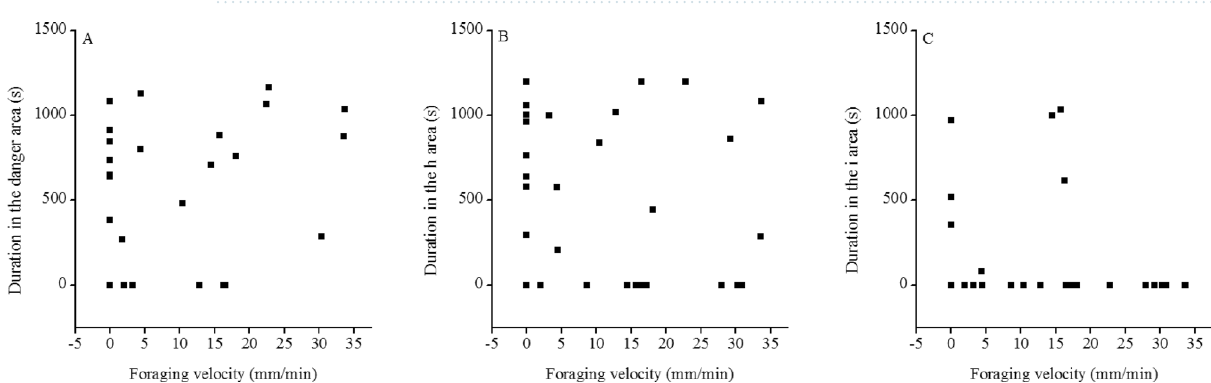
Figure 3. Experiment 3: correlation between foraging velocity and the duration in the danger area (g area) in Mesocentrotus nudus when they encountered conspecific alarm cues on the way to forage ( A ), correlation between foraging velocity and the duration in the h area ( B ), correlation between foraging velocity and the duration in the i area ( C ) when the kelp was around 5 mL and 0.5 mL conspecific alarm meters 12 . Therefore, the current result indicates adding conspecifics alarm cues around the kelp is an effectively approach to reducing the threat from sea urchins to the kelp beds. Conspecific alarm cues that appear between the kelp and the sea urchins significantly prevent foraging behav- ior of sea urchins (unpublished data). However, it remains unknown of whether adding conspecific alarm cues in critical areas probably prevent fasted sea urchins to forage. Sea urchins tend to move from the barrens with scarce macroalgae to the kelp beds with plentiful macroalage 13 . Starvation significantly enhances the foraging frequency of the sea urchin Echinometra mathaei 8 . Thus, effectively preventing fasted sea urchins from foraging the kelp is important for the management of kelp beds. In the present study, sea urchins fasted for 21 days did not move through the area with conspecific alarm cues when conspecific alarm cues appeared between the kelp and sea urchins. Besides, duration in the escape (f area) and danger (e area) areas did not differ significantly in the sea urchins fasted for 21 days. These results suggest that escape behavior overwhelms foraging behavior in fasted sea urchins when they are exposed to conspecific alarm cues. Although the sea urchin Heliocidaris cras- sispina fasted for one week was less sensitive to the cues of dead urchins 14 , M . nudus fasted for three weeks was sensitive to the conspecific alarm cues. It is likely that conspecific alarm cues from different sea urchin species have different effects on the fasted individuals. Together with our previous study, we suggest that conspecific alarm cues can effectively prevent the fasted sea urchins (at least M . nudus ) from foraging the kelp. Increasing evidences suggest that individual differences in foraging behavior are regulated by animal person- ality traits 15 . Bolder threespine sticklebacks Gasterosteus aculeatus tend to have strong foraging behavior 16 . Sea urchins overgraze the kelp through their strong foraging tendency. Thus, we hypothesize that the sea urchin with strong foraging ability probably moves through the area of conspecific alarm cues. The present study unexpect- edly found that there was no correlation between sea urchins with strong foraging velocity and the duration in the danger area (g area). There was no significant correlation between sea urchins with foraging velocity and the duration in the h area. The duration in the i area of sea urchins also showed no significant correlation with the